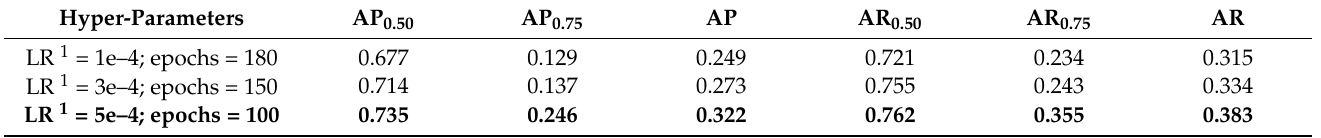
Table 1. Performance of the HRNet-W48 showing the used hyper-parameters for model training and structure. Object keypoint similarity (OKS) metrics state the average precision with threshold values of 0.50 (AP 50 ) and 0.75 (AP 75 ); these were averaged over thresholds from 0.5 to 0.95 (AP) as well as the average recall with threshold values of 0.50 (AR 50 ) and 0.75 (AR 75 ) averaged over thresholds from 0.50 to 0.95 (AR). We used a batch size of 64 for all tests. Best-performing values are printed in bold. We evaluated the model performance every 10 epochs to select the best-performing model and then listed the performance for this epoch.